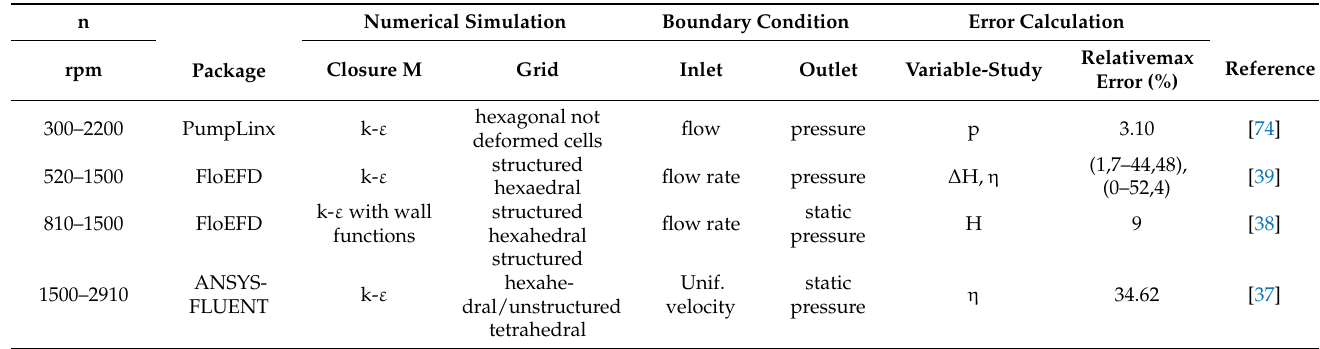
Table 3. Radial pumps analysis with variable speed